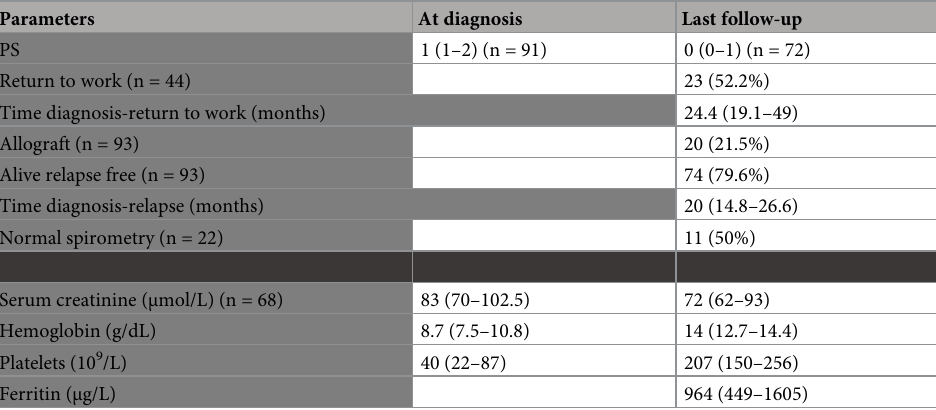
Table 5. Clinical and biological characteristics of patients alive. N =